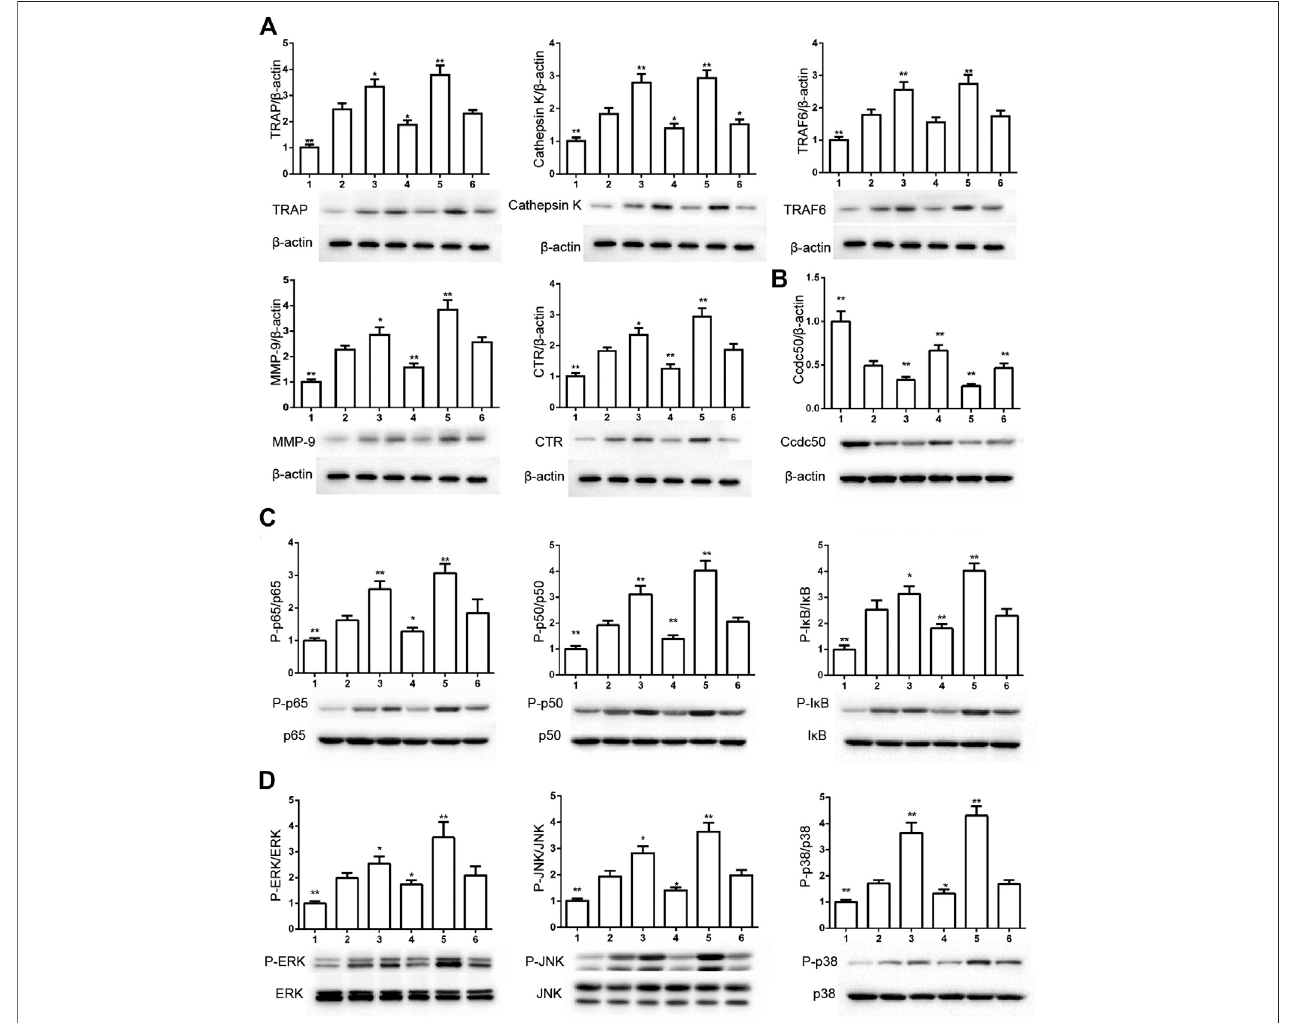
FIGURE 6 | Ccdc50regulates NF- κ B,and MAPK pathways. (A) The expressions ofTRAP, cathepsin K,TRAF6,MMP9,and CTR wereanalyzed bywestern blot. (B) ChangesinCcdc50inosteoclastogenesis. (C) Phosphorylationofp65,p50,andI κ Basanalyzedbywesternblot. (D) PhosphorylationofJNK,ERK,andp38asanalyzedby western blot. 1) RAW264.7 cells. 2) RAW264.7 cells infected with Lv-NC, induced with M-CSF, RANKL. 3) RAW264.7 cells infected with Lv-NC, induced with M-CSF, RANKL, and 30 ng/ml myostatin. 4) RAW264.7 cells infected with Lv-Ccdc50, induced with M-CSF, RANKL. 5) RAW264.7 cells infected with